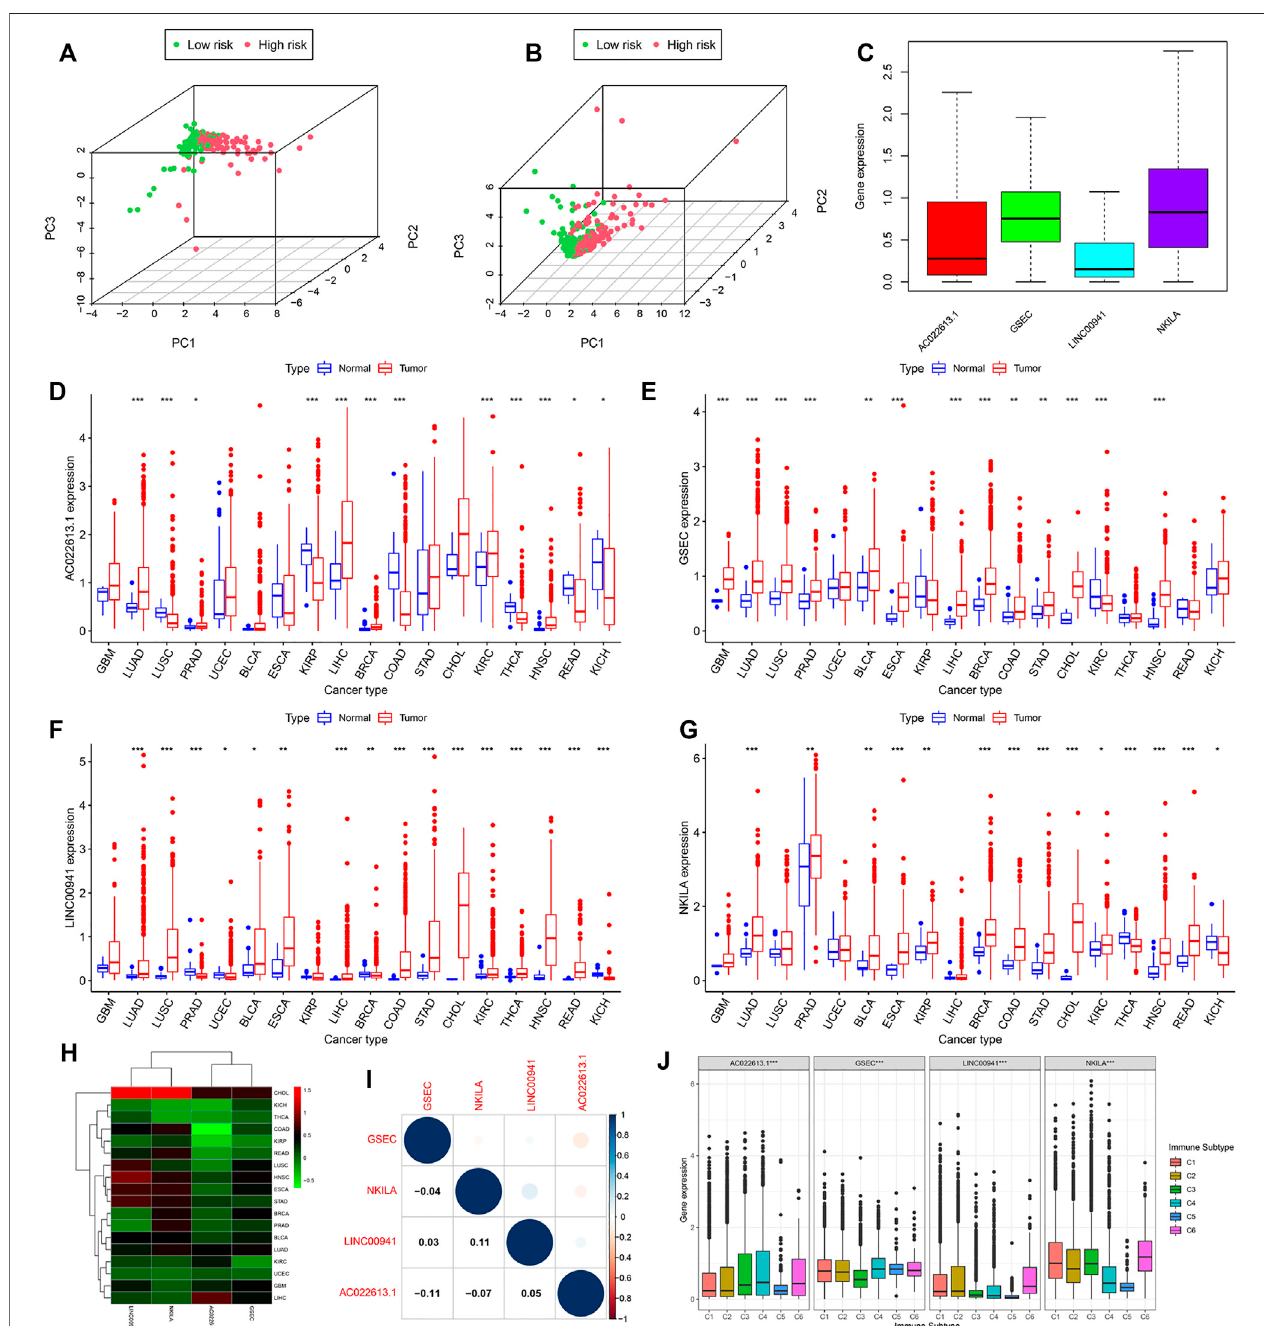
FIGURE9| ExpressionoflncRNAs inpan-cancer whichhad more than fi venormalsamples.Principal componentanalysisbased onthe lncRNAs ofthemodel (A) in the training and (B) validation cohorts. (C) Expression of lncRNAs of the model is shown by the boxplot in pan-cancer. (D – G) In 18 cancer types, the difference of the expression of lncRNAs between tumor and normal samples is shown. (H) Heatmap showing the difference between normal and tumor samples of the expression of lncRNAs. (I) Relationship calculated by Spearman ’ s correlation analysis of the lncRNAs in pan-cancer. (J) Association tested by ANOVA in all cancers of four lncRNAs with six immune